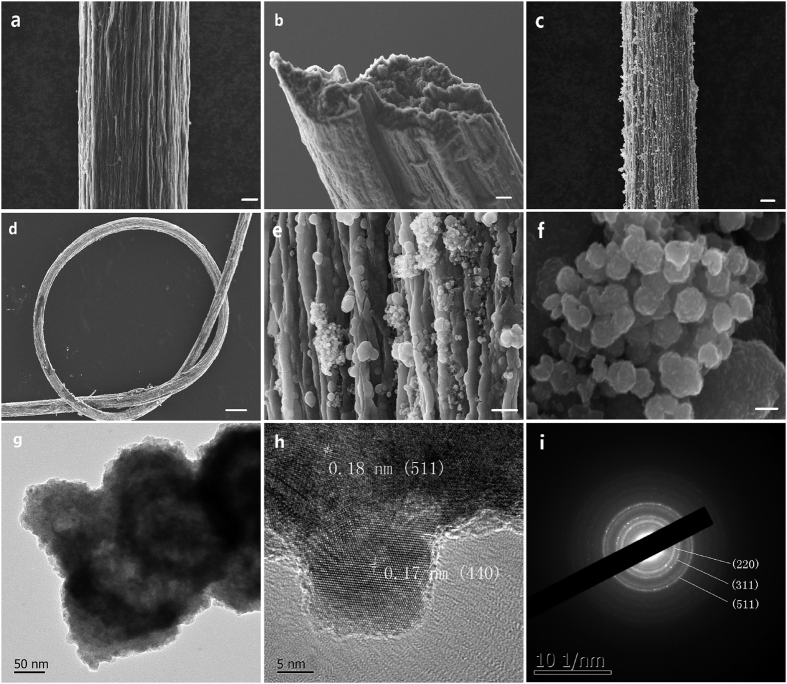
(a,b) SEM images of GF. (c–f) SEM images of GF/NiCo2S4. (g,h) TEM images of NiCo2S4. (i) SAED of NiCo2S4. Scar bar: (a) 10 μm; (b) 10 μm; (c) 10 μm; (d) 200 μm and (e) 1 μm.